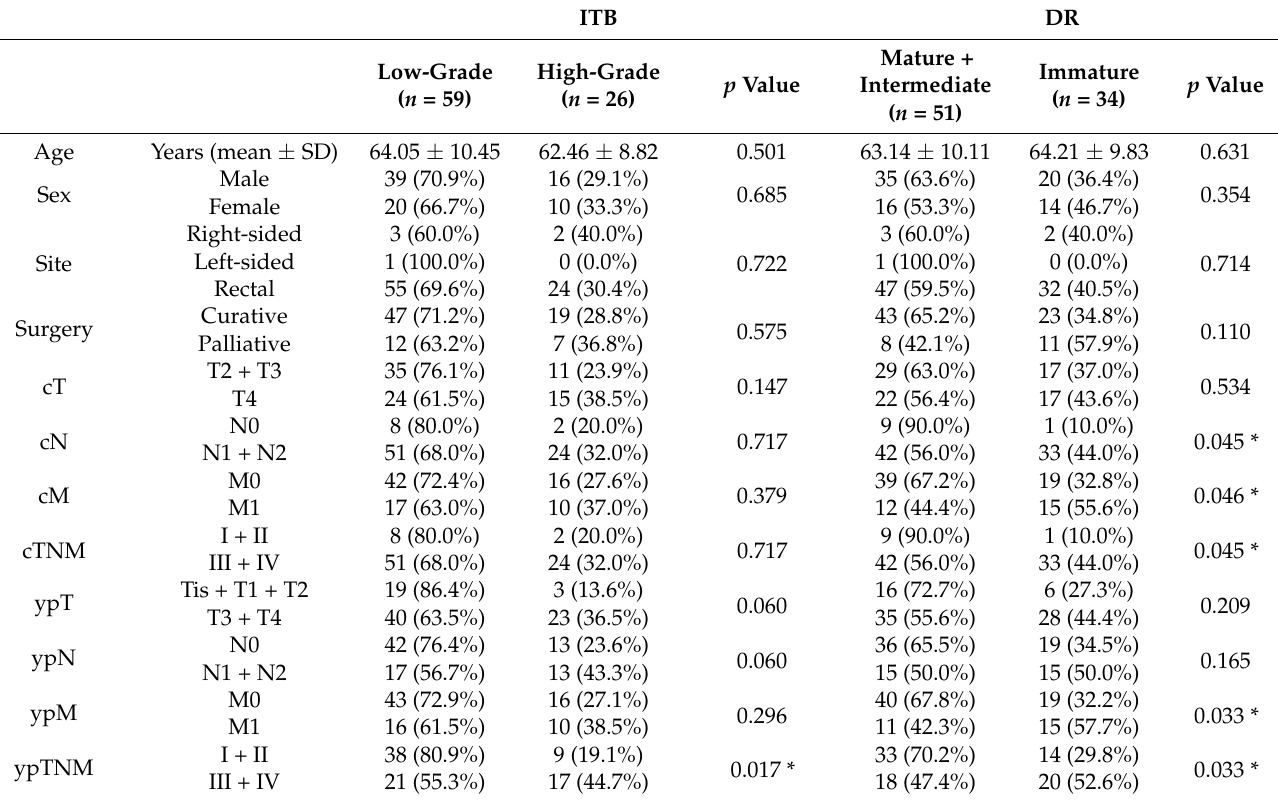
Table 1. Comparison of clinicopathological and histological parameters, intratumoral budding (ITB), and desmoplastic reaction (DR) between low- and high-grade ITB and mature, intermediate and immature DR in pretreatment biopsy samples